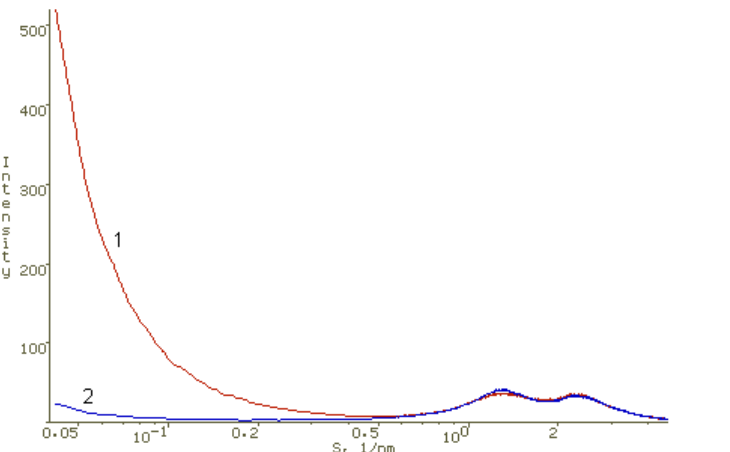
Figure 9. Experimental X-ray diffraction pattern of a chitosan-PVP film (1) with a mass ratio of these polymers of 1:2 and a model X-ray diffraction pattern of such film (2) obtained by summation of X-ray scattering intensity of chitosan and PVP films taken in a 1:2 proportion. Logarithmic scale along the abscissa axis.